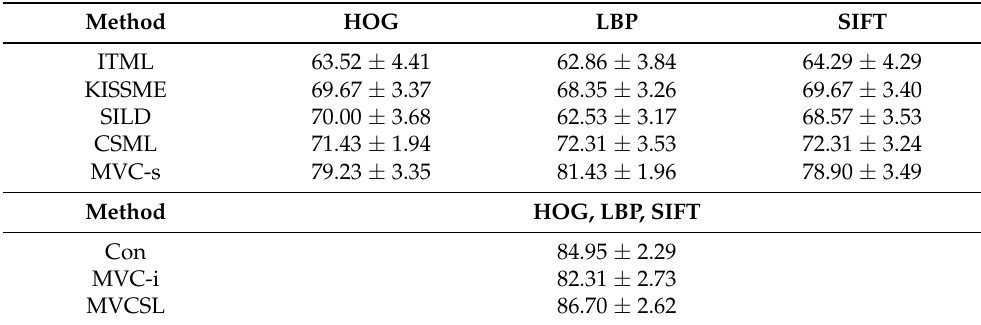
Table 1. Mean accuracy and standard error (%) of different methods on the FGFV dataset under the image restricted